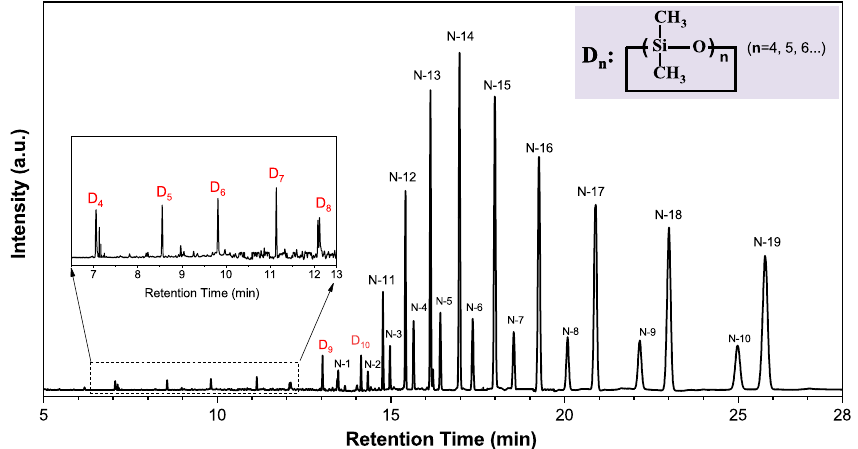
Figure 1. Gas chromatogram showing the homologous peak marks of the extracts in virgin sili- cone